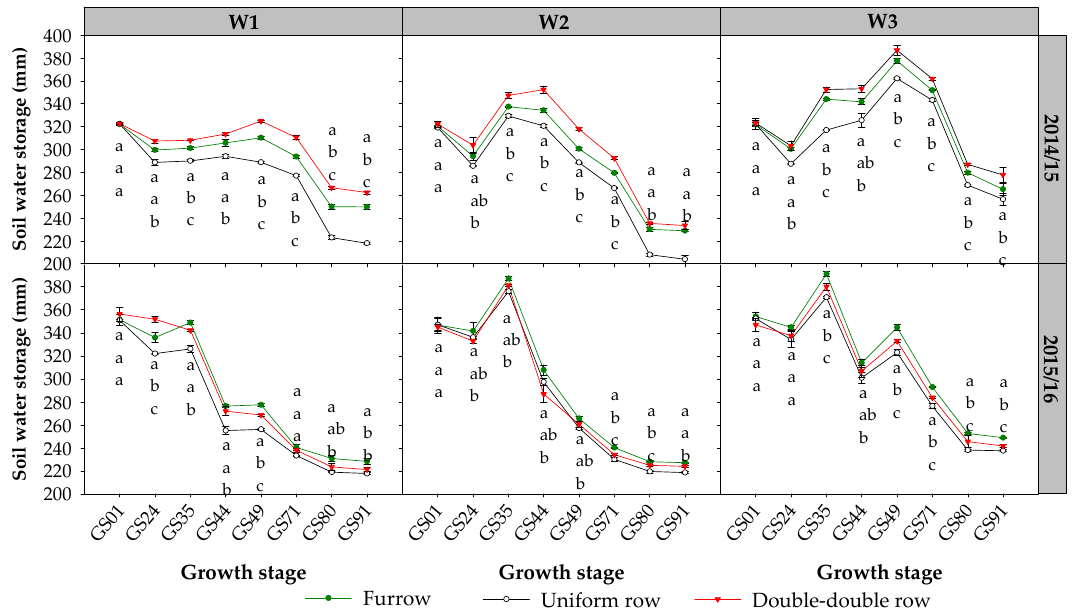
Figure 6. Effects of planting modes and irrigation on soil water storage during the growing season. W1, irrigation 50 mm water each at growth stage 34 (GS34) and GS48; W2, irrigation 100 mm water at GS48; and W3, irrigation 100 mm water each at GS34 and GS48. The same letters are not significantly different according to the least significant difference at 0.05. The bars are the standard error.